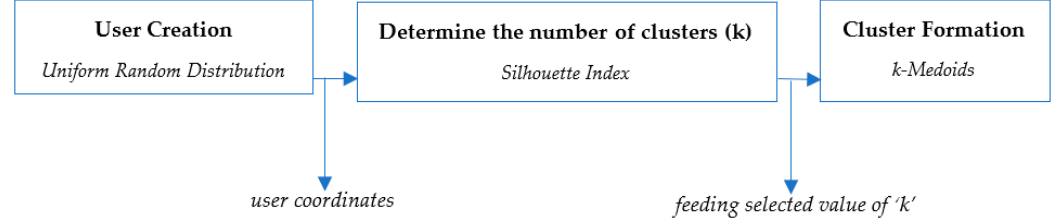
Figure 4. The process of determining the value of ‘ k ’, the number of clusters. An Example